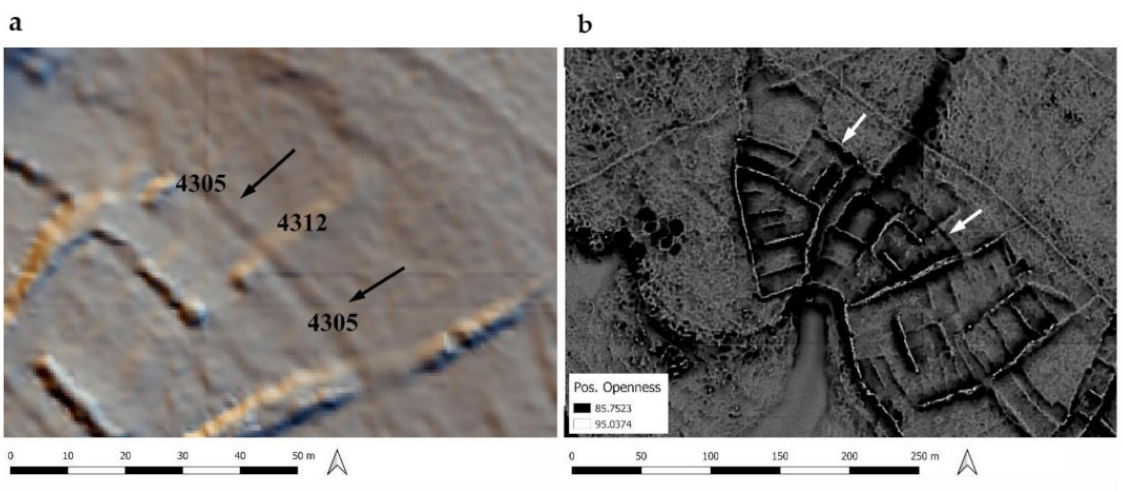
Figure 26. A stratigraphically younger terrace slope (see arrows) runs along the south-west edge of the forest (compare Figures 13d and 15c). Visualization: ( a ) MH based on dense_veg filter setting, ( b )